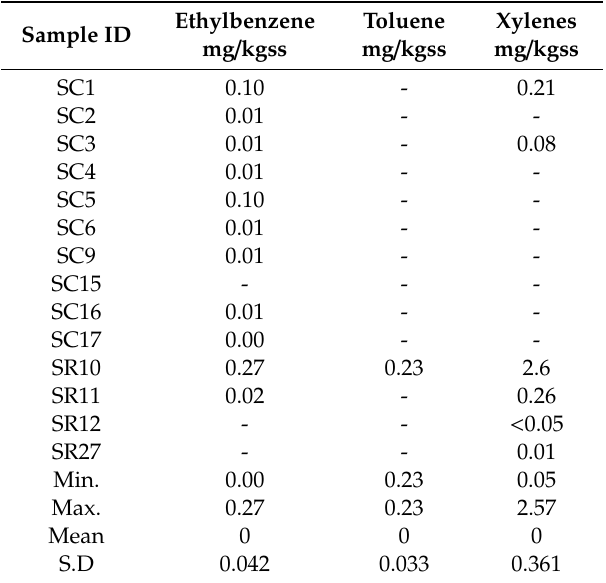
Table 8. LNPL concentration in soil samples.